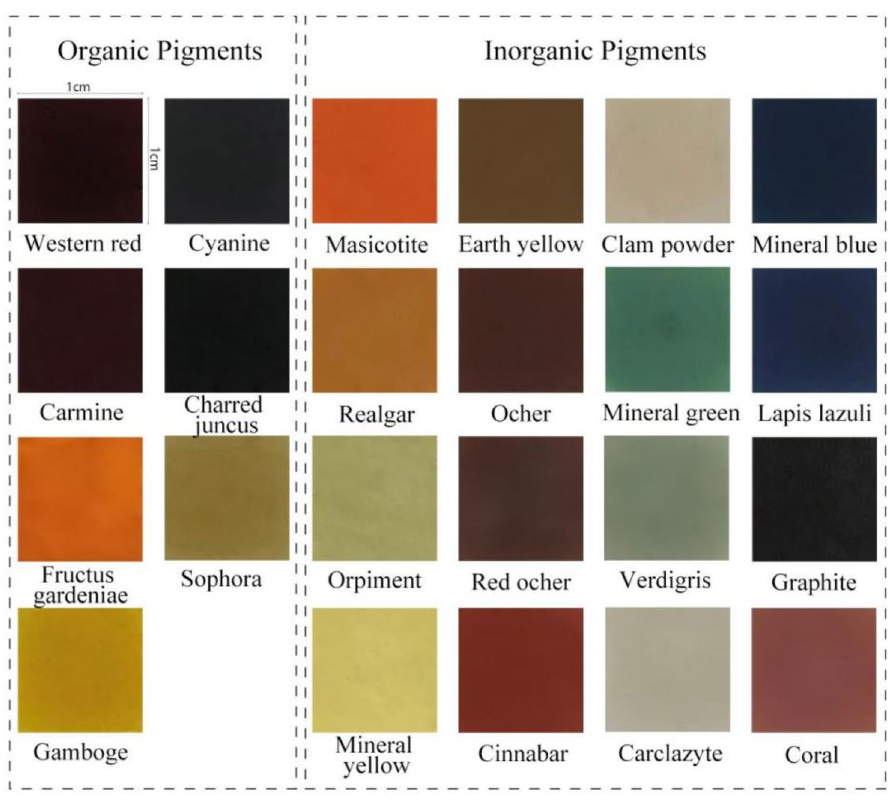
Figure 2. Experimental sample